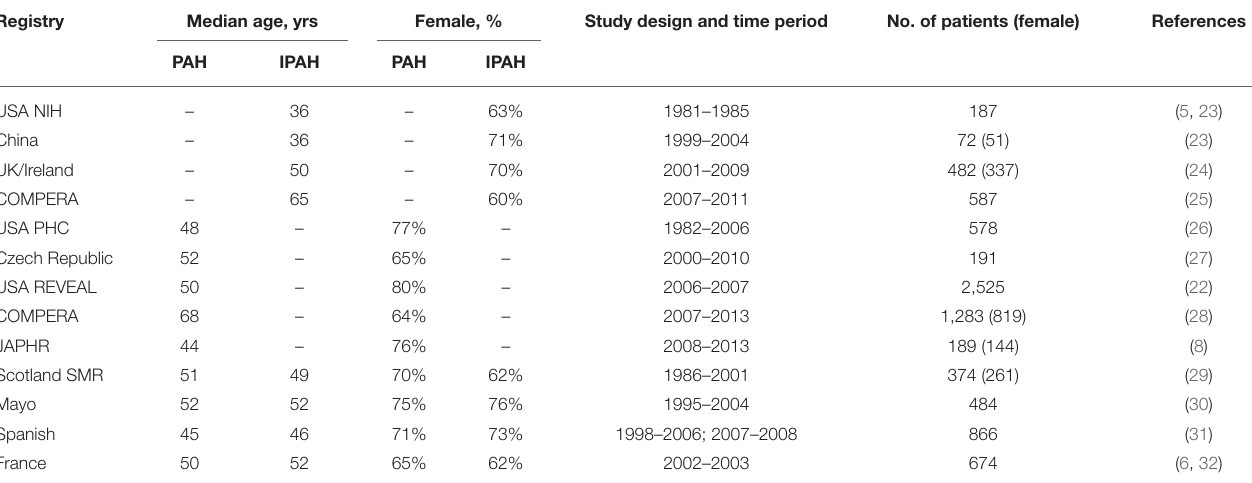
TABLE 1 | Proportion of female patients in major PAH